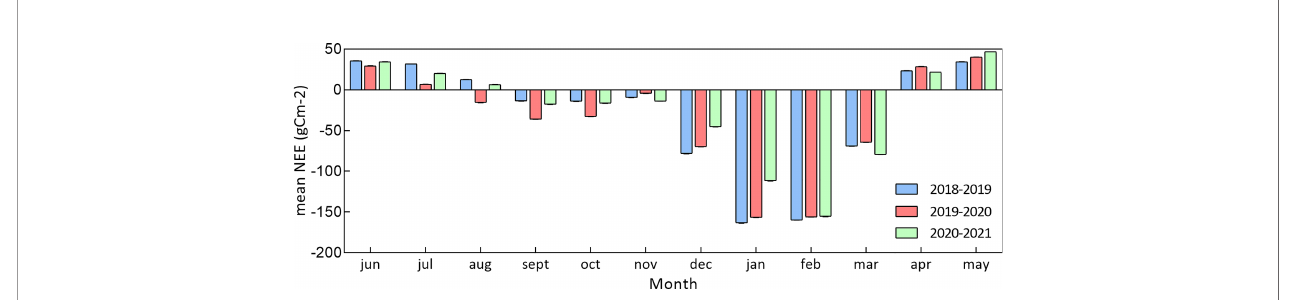
FIGURE 7 | Mean and standard error of Inland Pampa monthly NEE for the 2018 – 2019, 2019 – 2020, and 2020 – 2021 campaigns.